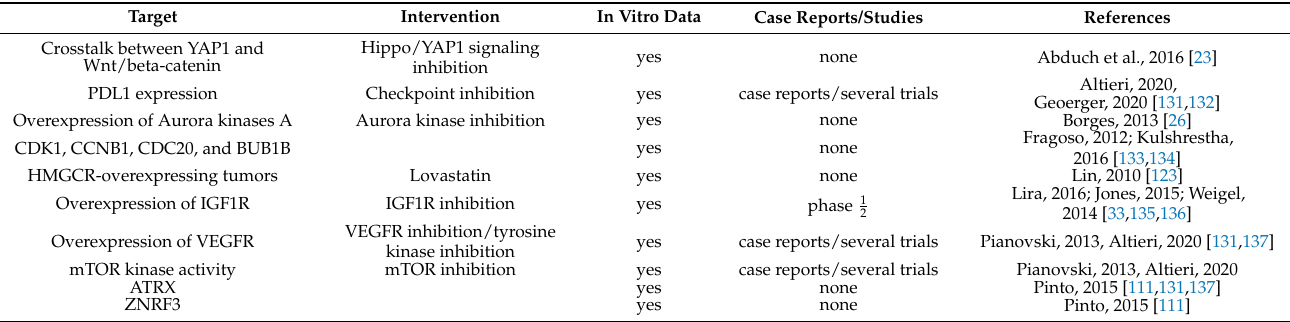
Table 6. Druggable